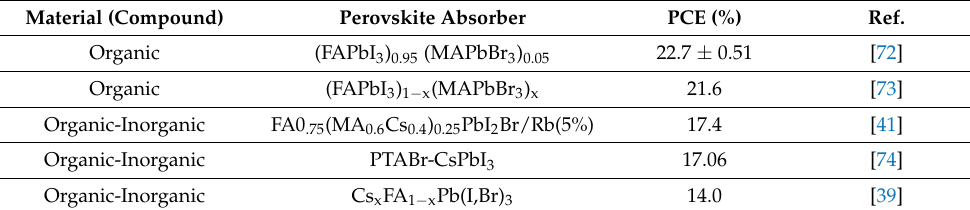
Table 3. List of examples of efficiency performance-related material types and perovskite absorber chemical